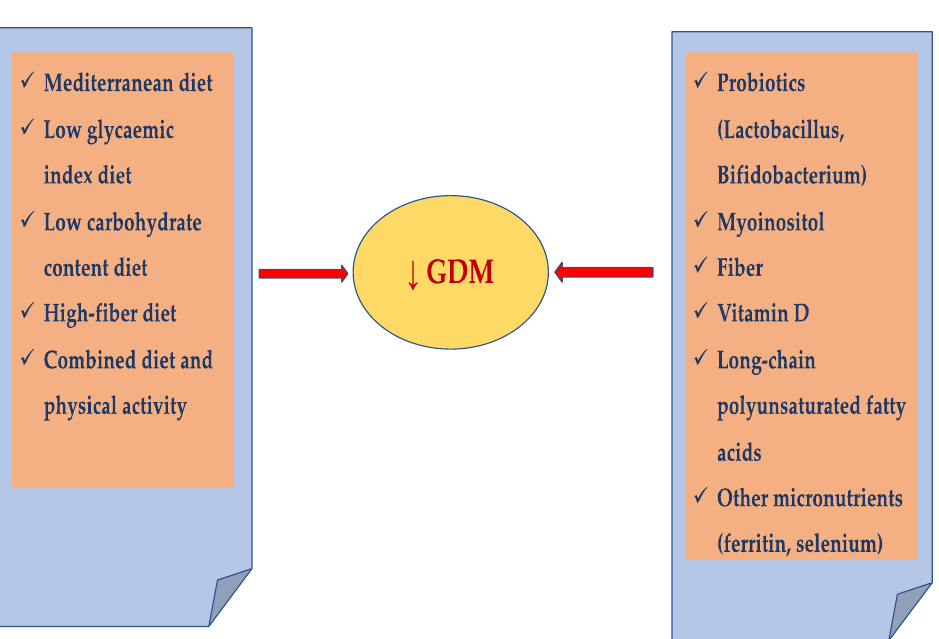
Figure 1. Diet and supplements as potential factors in GDM prevention.